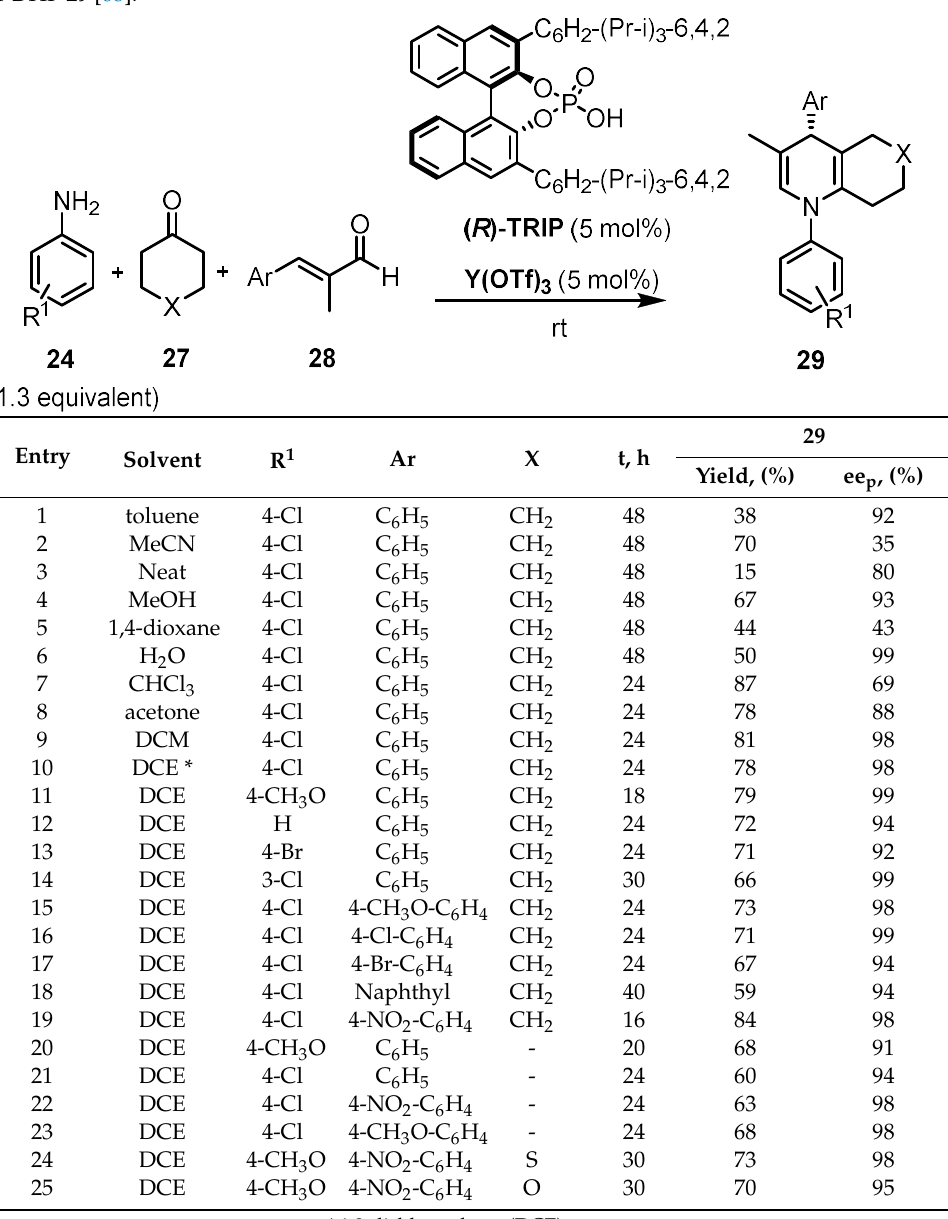
Table 11. ( R )-TRIP catalysed synthesis of fused 1,4-DHPs 31